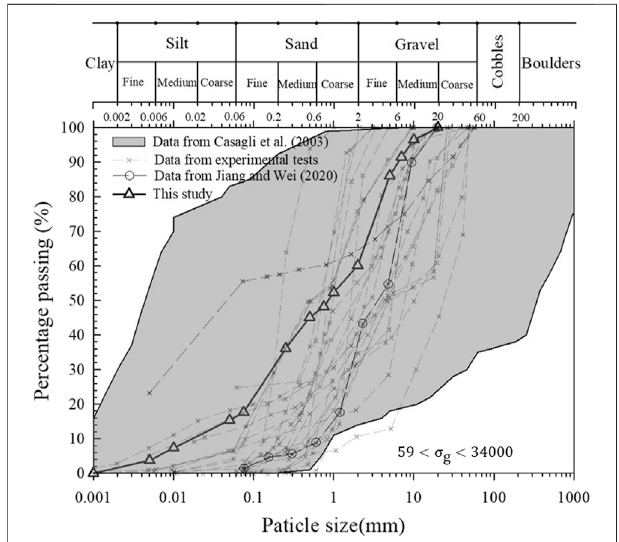
FIGURE3| Theshaded regionisthecumulativegrainsizedistribution of 42 landslide dams in the Northern Apennines (Casagli et al., 2003) and the data points marked as crosses are data from the experimental tests of Yan and Cao, 2009; Cao et al., 2011; Xu et al., 2013; Shi et al., 2014; Yang et al., 2015; Zhou et al., 2015; Jiang et al., 2017; Jiang et al., 2018a; Jiang et al., 2018b; Xiong et al., 2018; Jiang and Wei, 2020; Jiang et al., 2020; Zhu etal.,2020.Thesolidlinerepresentsthegrain-sizedistribution ofthemodeled landslide